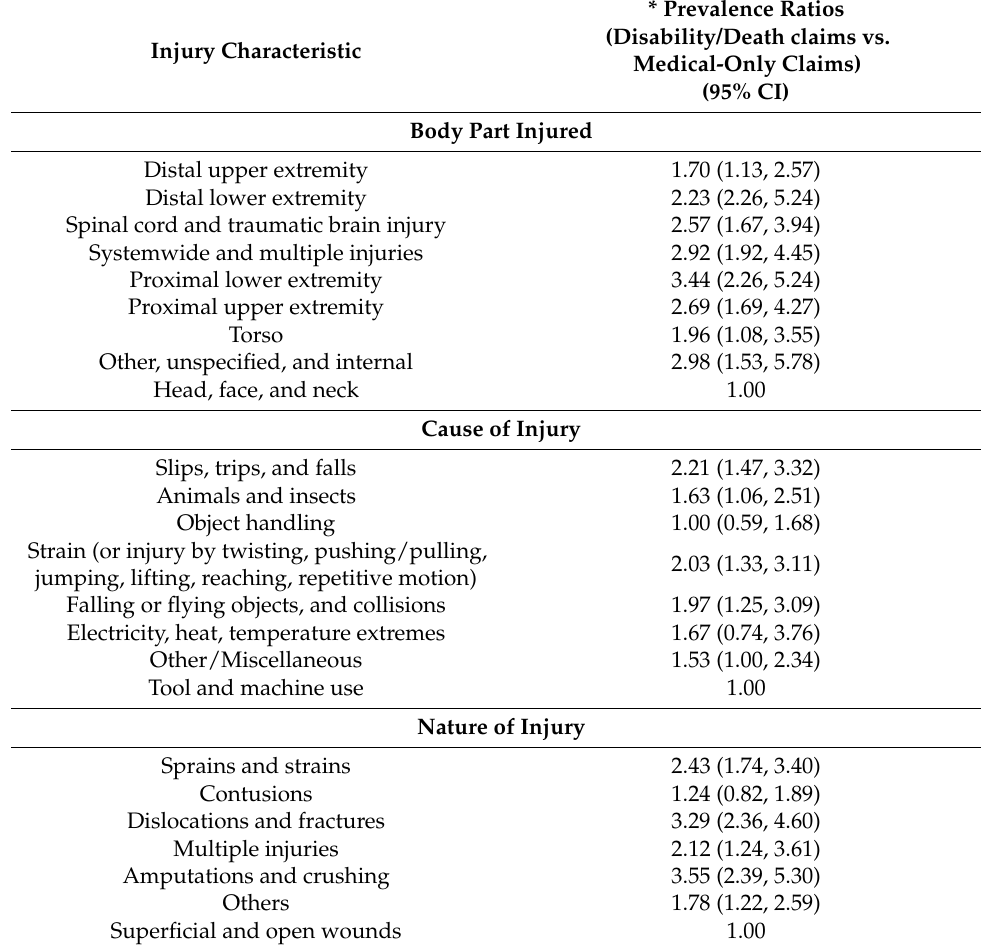
Table 2. Prevalence ratios for disability/death claim versus medical-only claim by body part injured, cause of injury, and nature of injury (n = 1000). Injury Characteristic